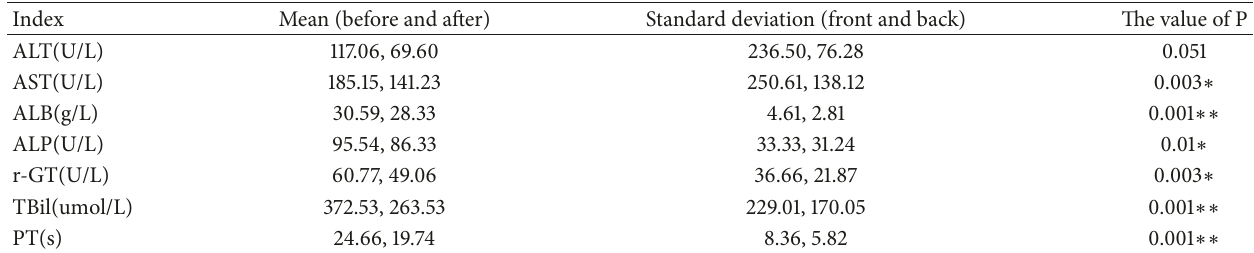
Table 6: Clinical analysis of hepatic failure treated by nonbioartificial liver treatment.